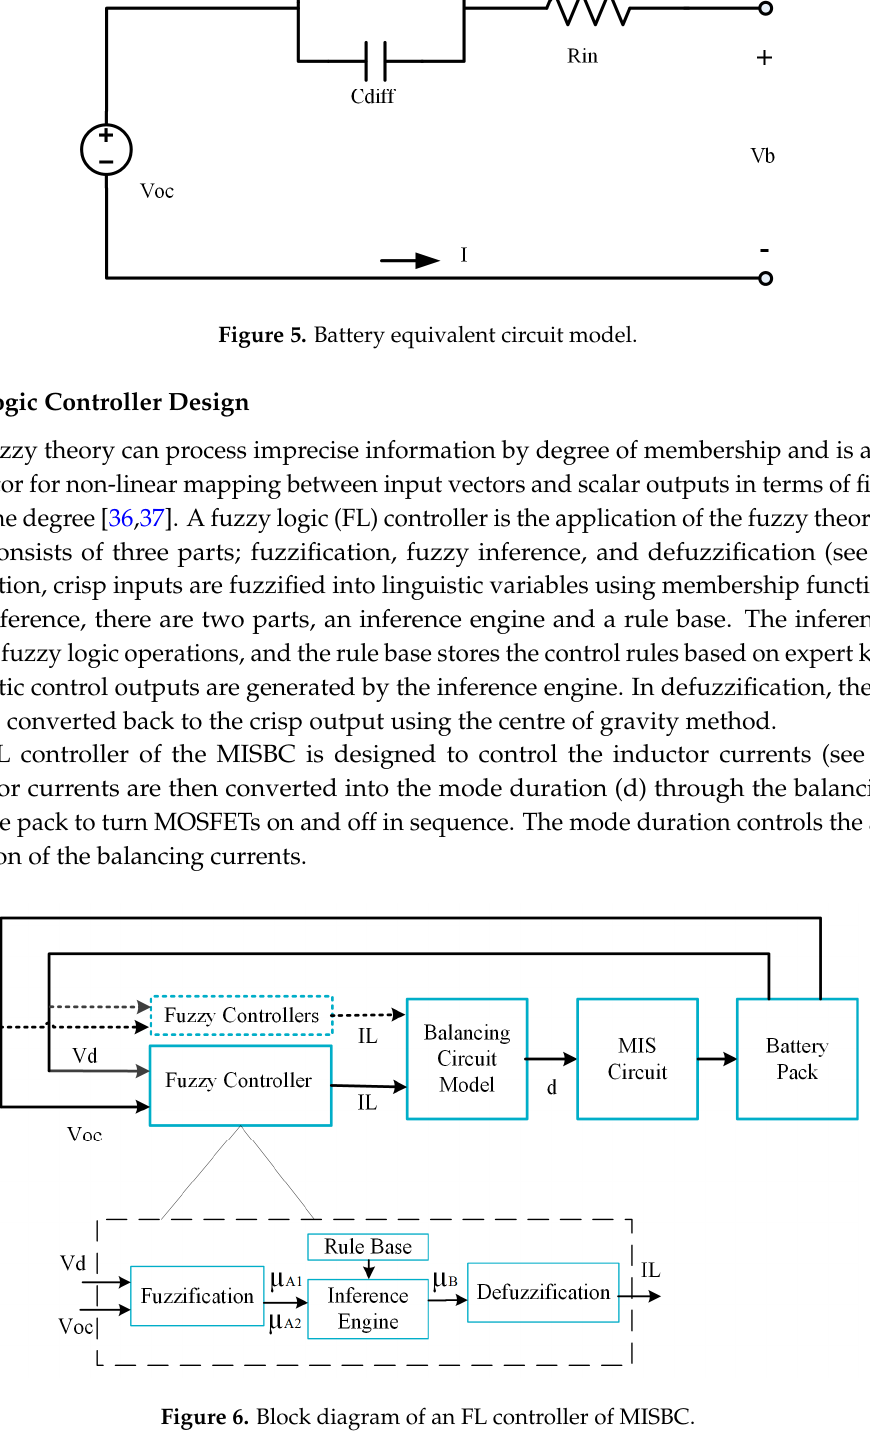
6 of 18 Figure 4. Simulation results for MSIBC with constant equal mode duration. 2.3. Balancing Criterion oc V